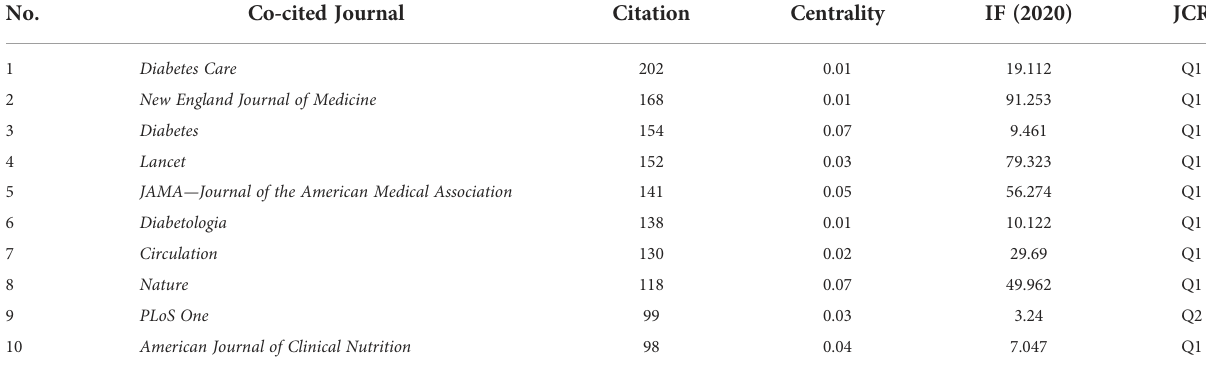
TABLE 1 The top 10 co-cited journals related to RNA methylation in DM and its complications.